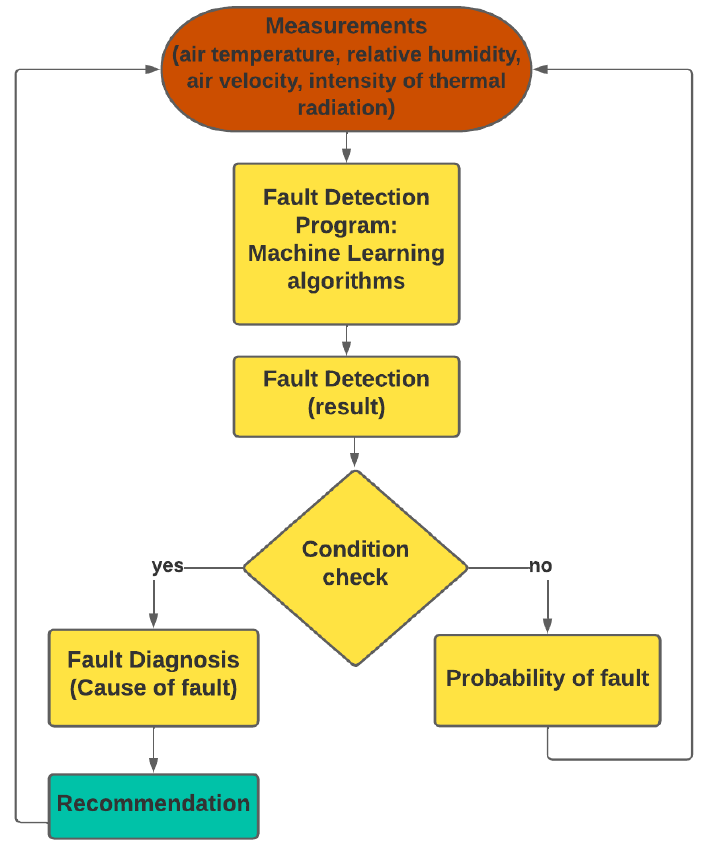
Figure 7. Fault detection and diagnosis in microclimate